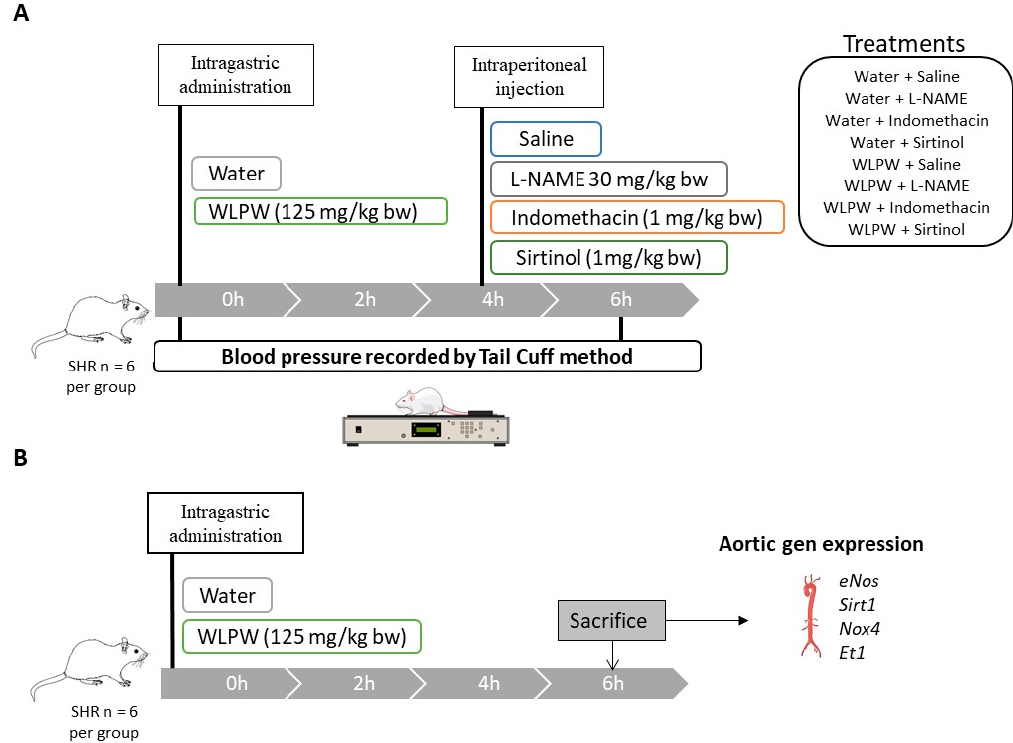
Figure 1. Graphical representation of the experimental design for N ω -nitro-L-arginine methyl ester hydrochloride (L-NAME), indomethacin and sirtinol study in spontaneously hypertensive rats (SHR) ( A ), and graphical representation of the experimental design used to study the effects of wine lees powder (WLPW) on the endothelial function ( B ).